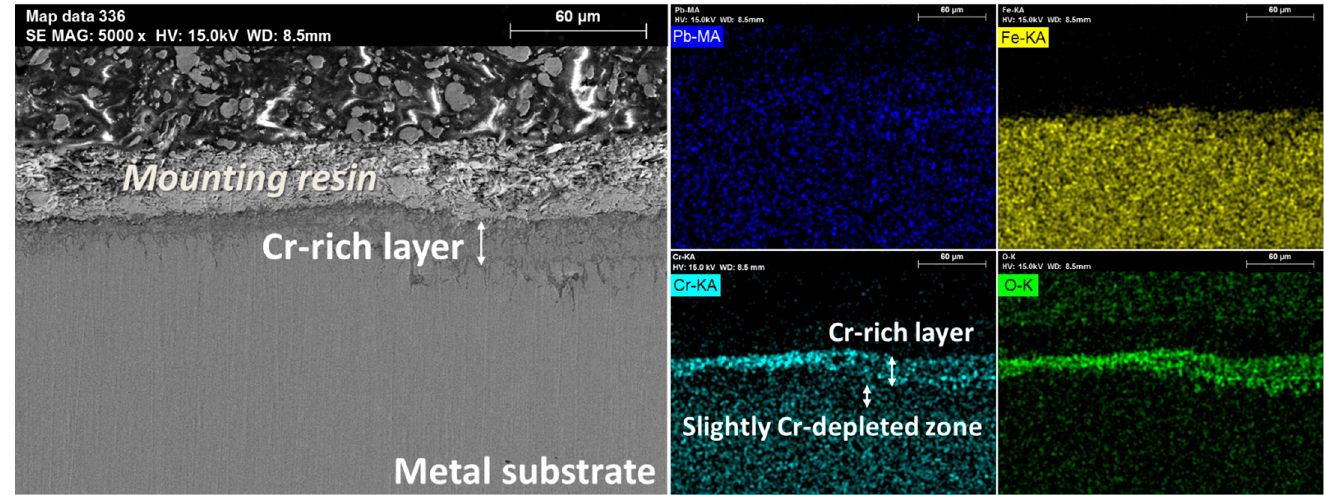
Figure 6. Cr-rich spinel layer and a slightly Cr-depleted region on T91 after 2000 h at 600 °C.